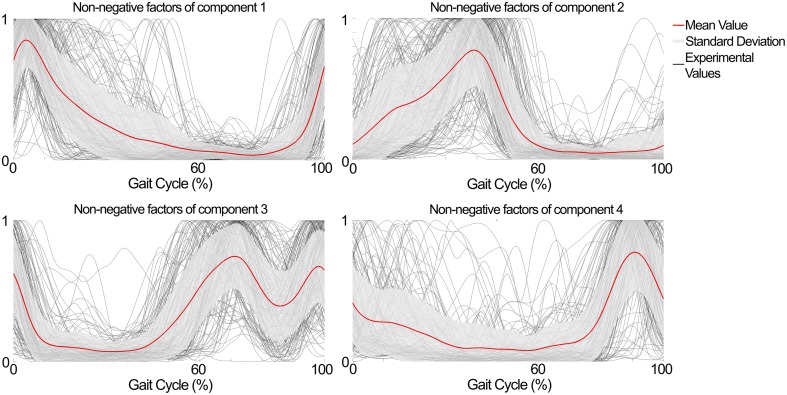
Subject- and condition-generic non-negative factors (red line) obtained by averaging the experimentally obtained profiles (gray lines) across subjects and conditions (speed × elevation). The non-negative factors have consistent shape and timing between the subjects and conditions.